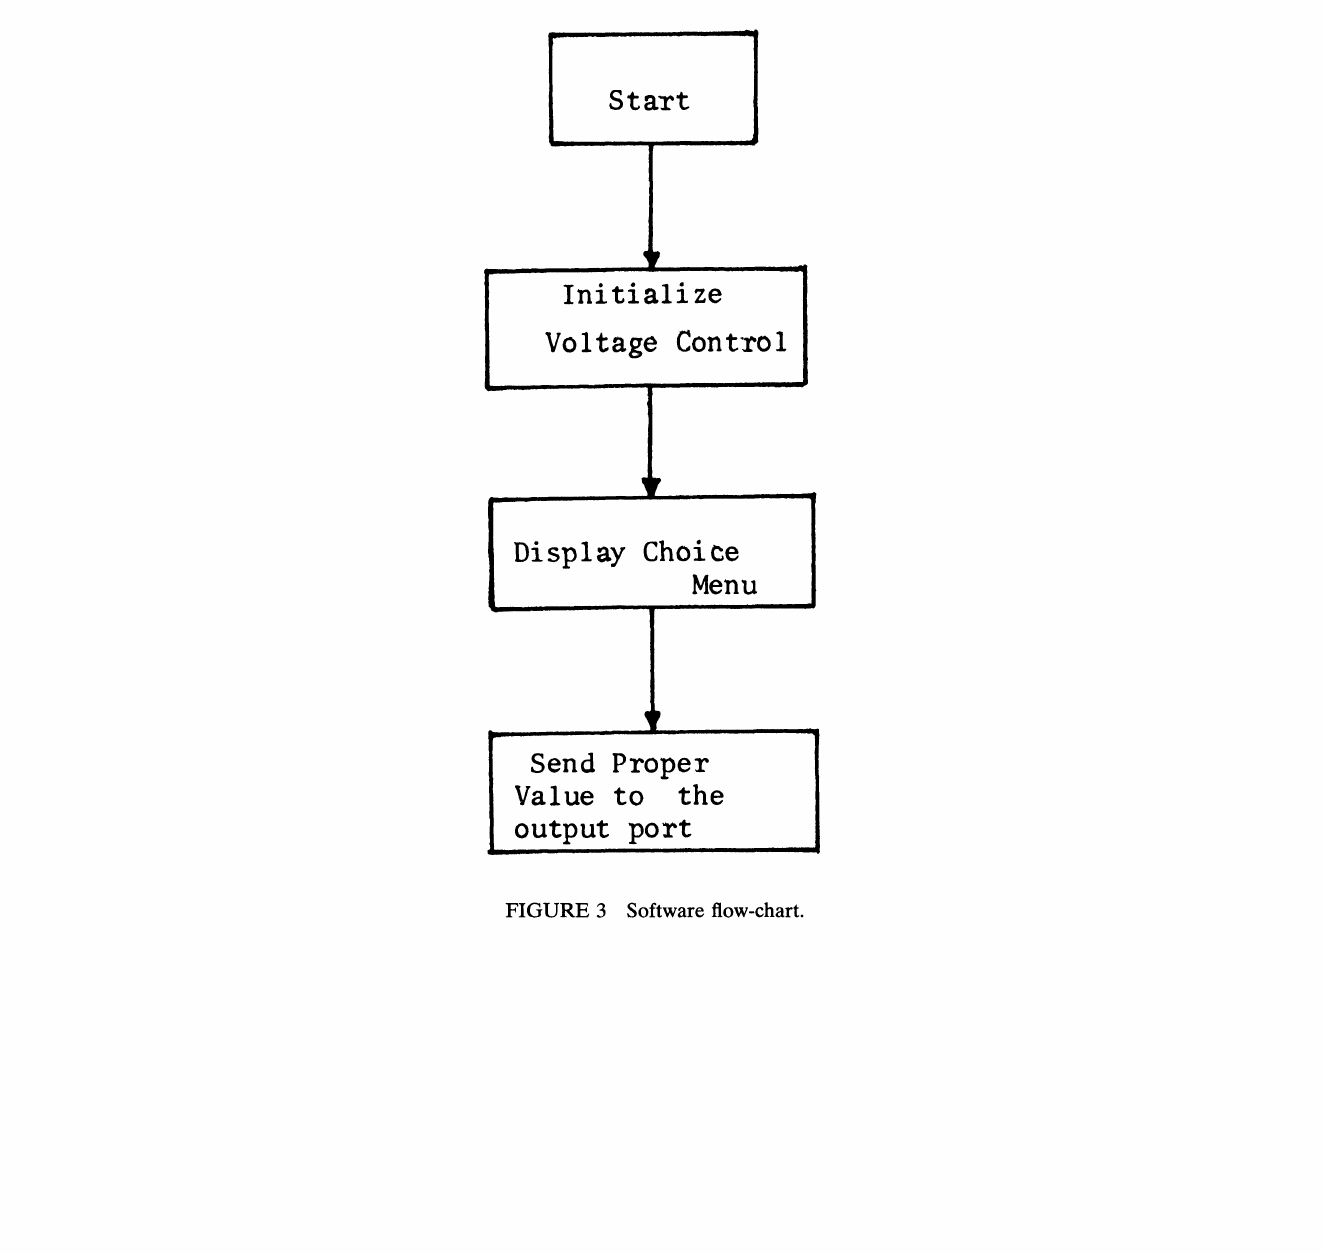
FIGURE 3 Software